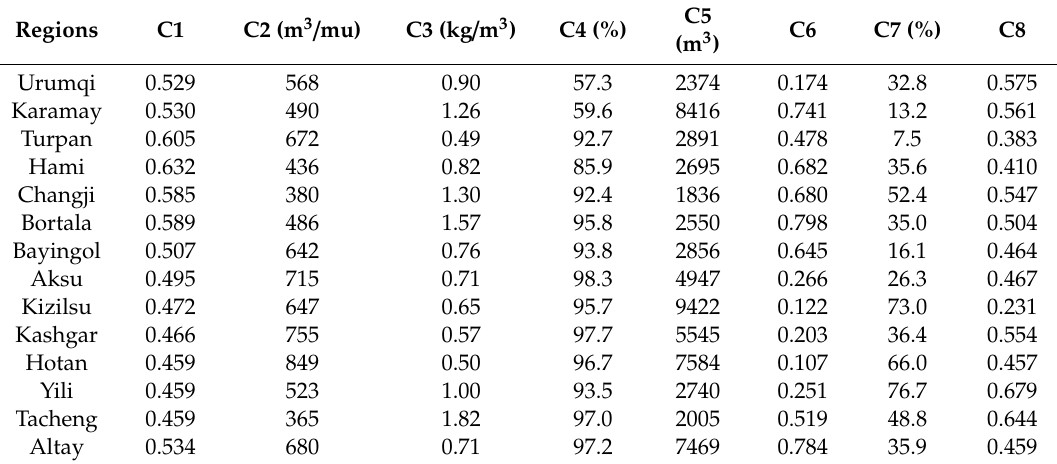
Table 1. Evaluation indicators values of 14 administrative regions.